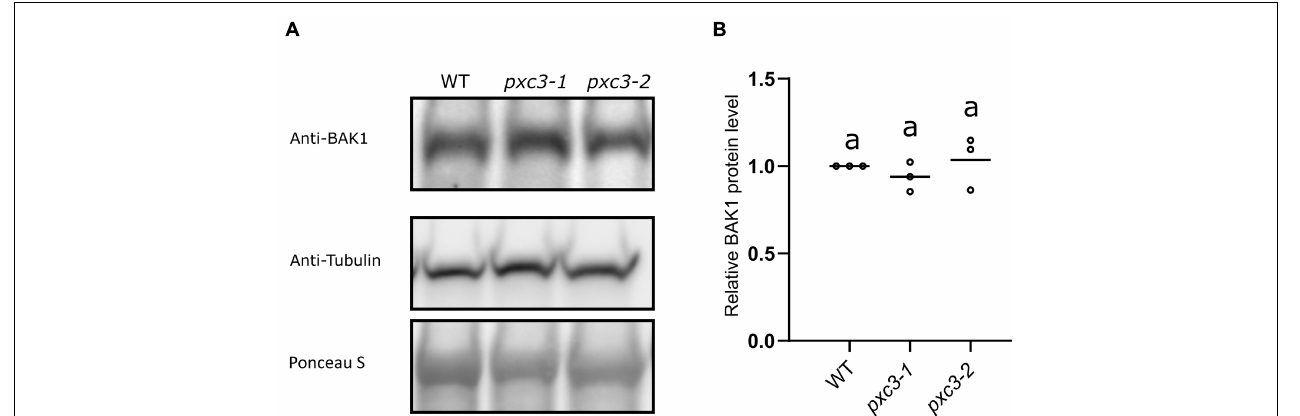
FIGURE 4 | BAK1 protein levels in wild type and pxc3 mutants. (A) Western blot analysis of BAK1 protein levels as detected by anti-BAK1 antibodies in wild type and pxc3 mutant seedlings. Blots were reblotted with anti-tubulin in two out of three performed experiments, all showing similar results. (B) Quantification of BAK1 protein levels in wild type and pxc3 mutants. For each experiment, BAK1 signal in the mutants was normalized by that in wild type. Individual data points for each experiment are shown. One-way ANOVA analysis was performed followed by Tukey’s test, and the lowercase letters indicate statistical differences ( P <